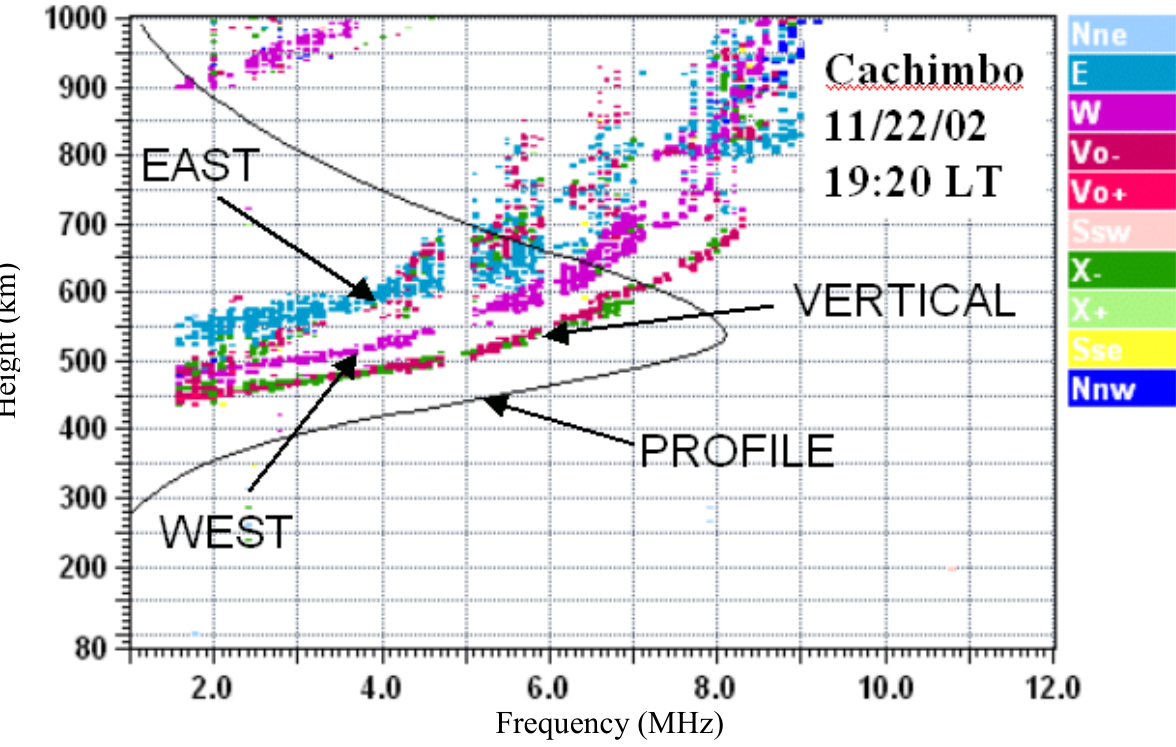
Frequency (MHz) Fig. 3. Multi-directional ionogram at Cachimbo for 22 November at 19:20LT showing echo traces from the west, east, and overhead, with Figure 3. Multi-directional ionogram at Cachimbo for November 22 at 1920 LT showing echo an overlay of the vertical electron density (plasma frequency) profile. traces from the west, east, and overhead, with an overlay of the vertical electron density (plasma frequency profile.